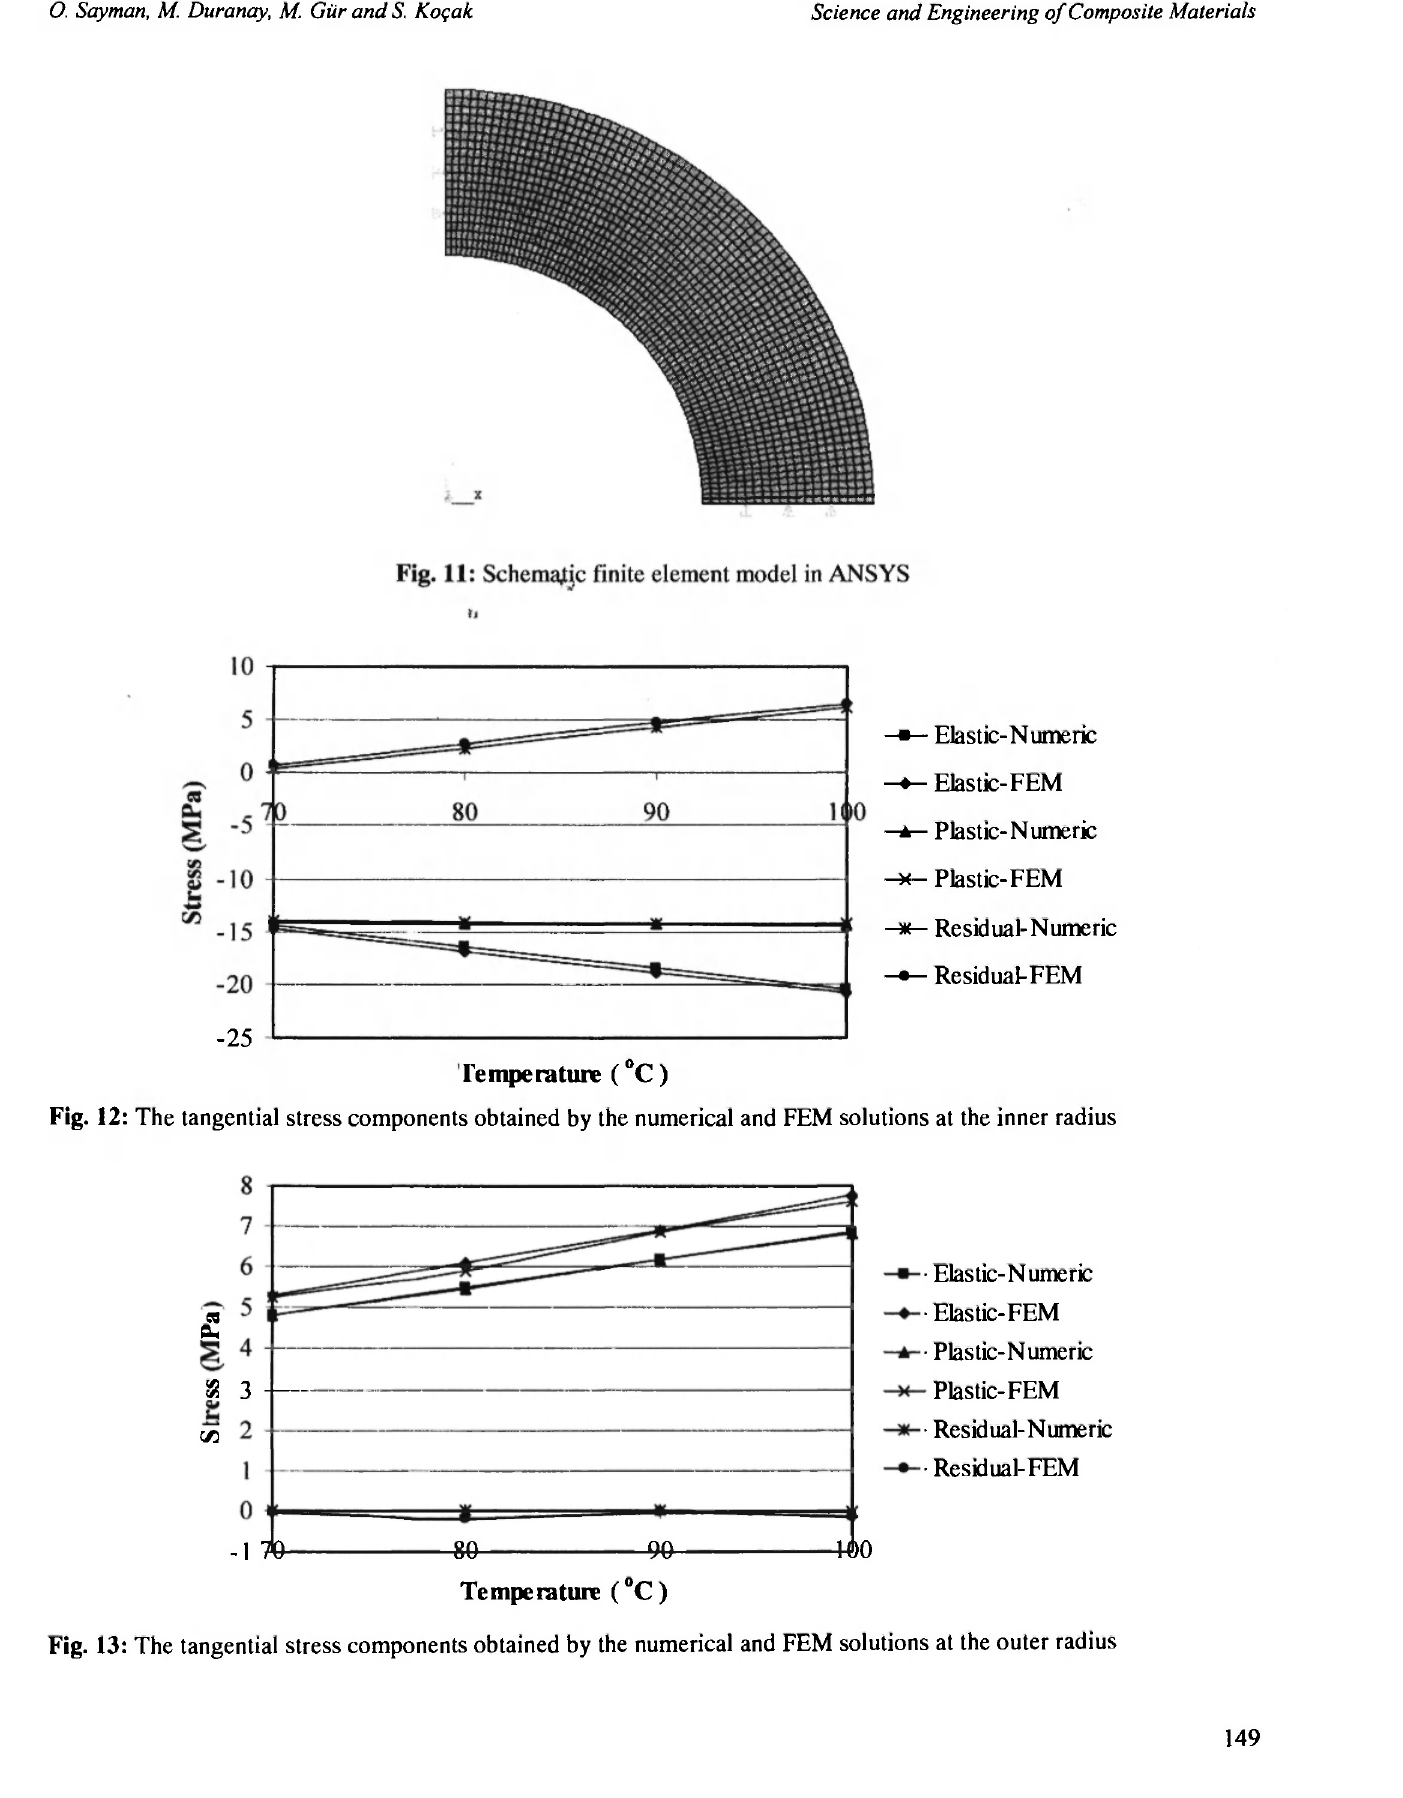
Fig. 13: The tangential stress components obtained by the numerical and FEM solutions at the outer